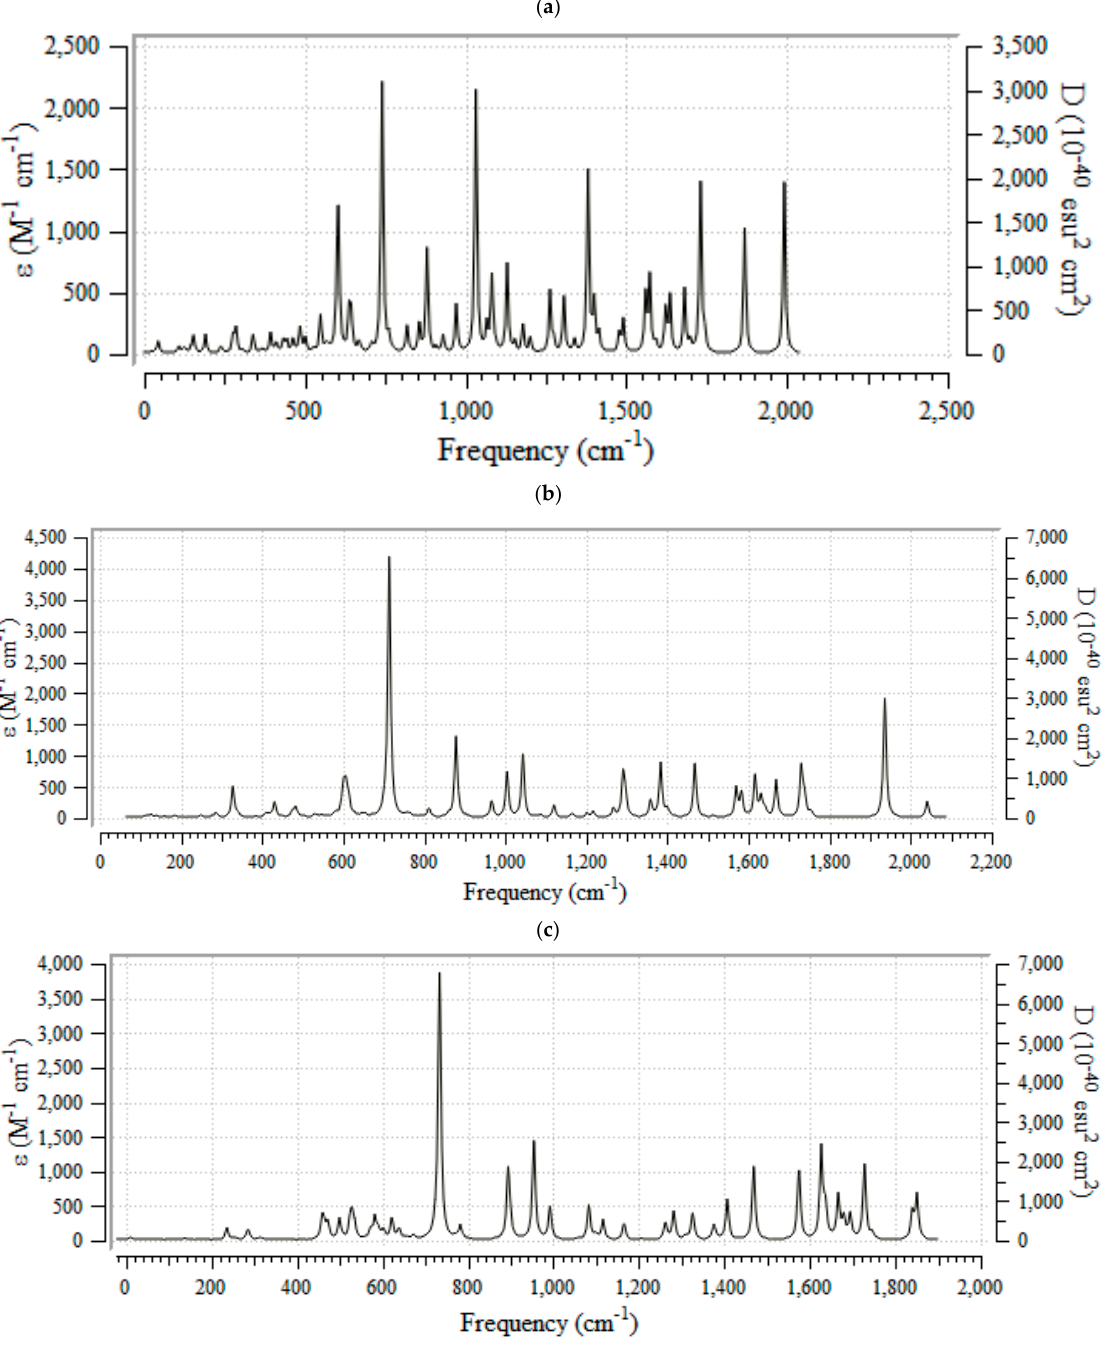
Figure 3. Changes of frequency (cm − 1 ) in the IR spectra for ( a ) Fe-, ( b ) Ni-, ( c ) Zn-doped graphene nanosheets as selective gas sensors.